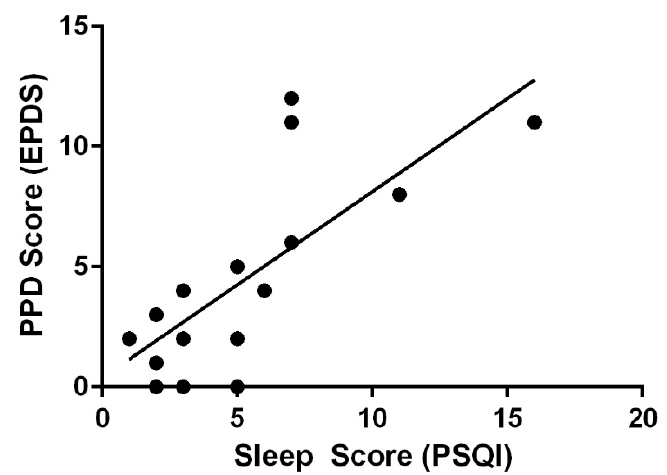
Figure 4. Sleep and PPD Scores at 12